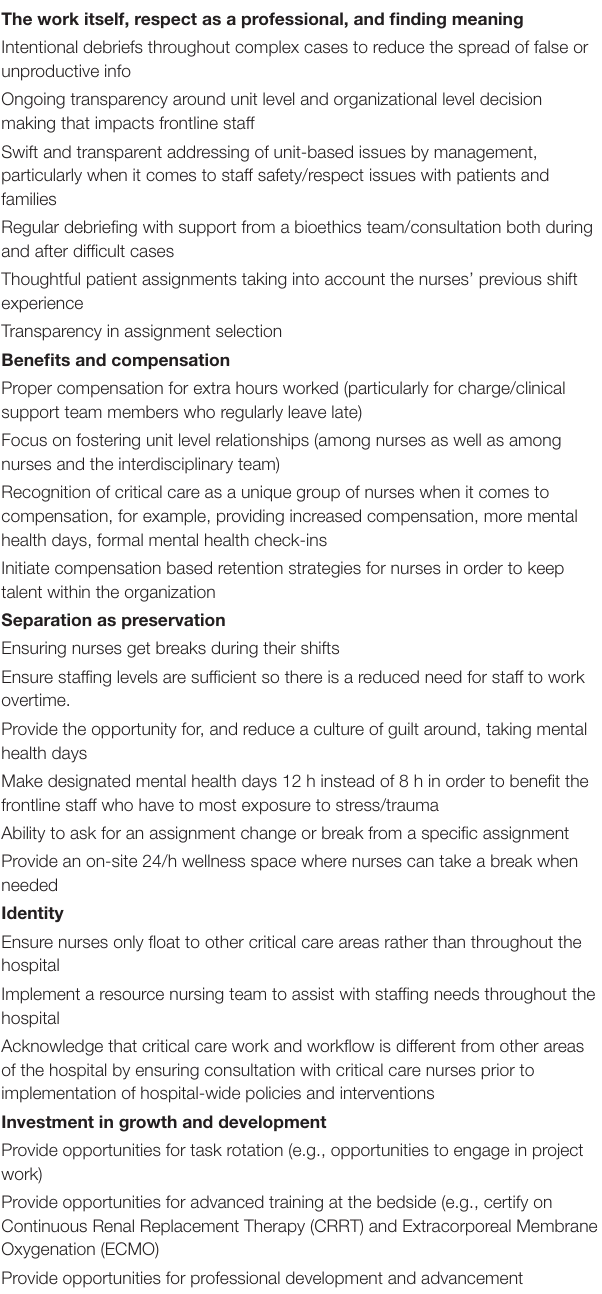
TABLE 1 | Recommendations for Nursing Unit and Organizational